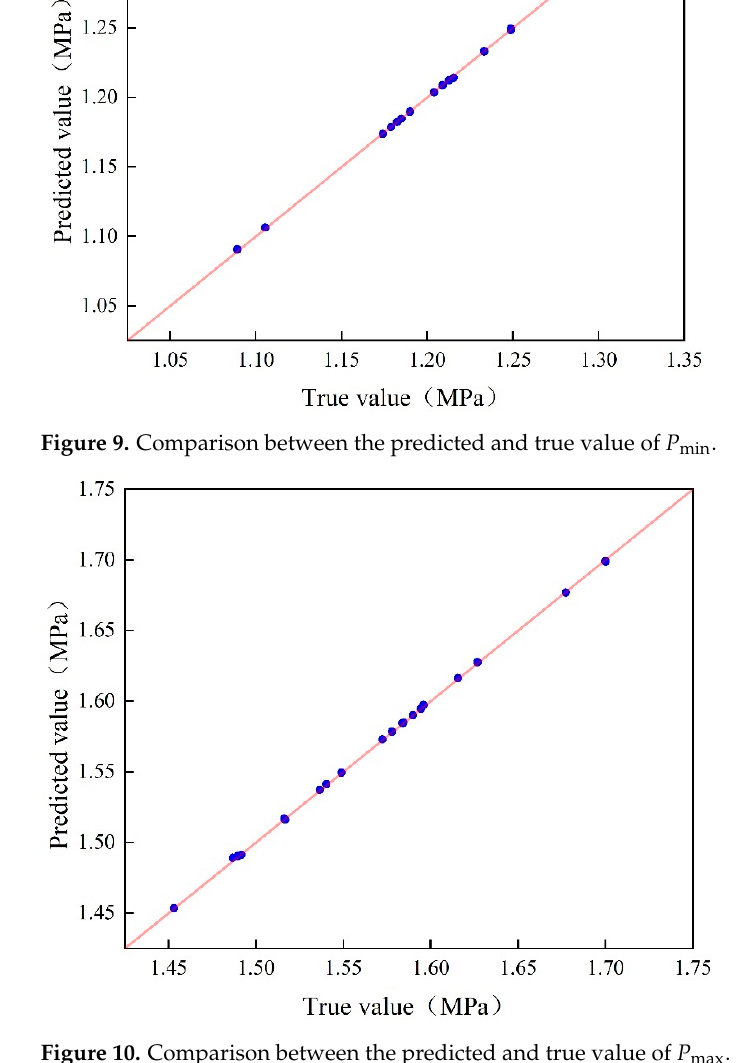
Figure 10. Comparison between the predicted and true value of P max .